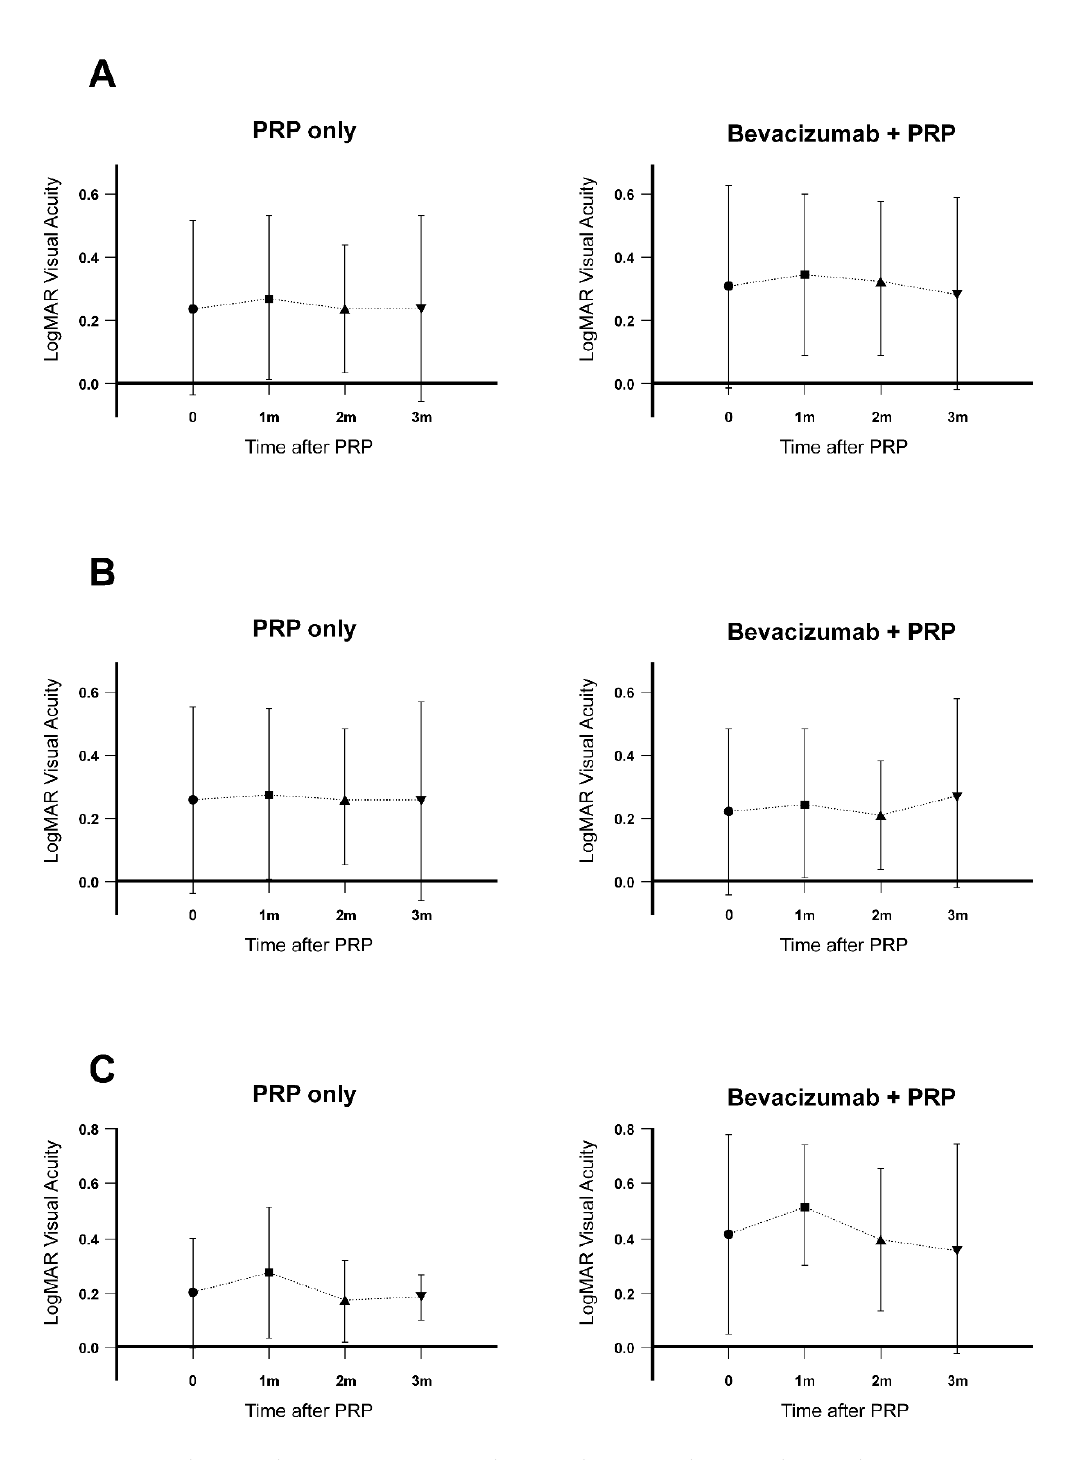
Figure 3. Visual acuity changes in patients with PDR who received PRP with or without preoperative IVB injection. Visual acuity was measured at baseline and one, two, and three months after PRP (** p < 0.05). ( A ) Overall changes in the logMAR visual acuity in the two groups. ( B ) Changes in the logMAR visual acuity in patients without baseline ME in both groups. ( C ) Changes in the logMAR visual acuity in patients with baseline ME in both groups. IVB: intravitreal bevacizumab, PRP: panretinal laser photocoagulation, PDR: proliferative diabetic retinopathy, logMAR: logarithm of the minimum angle of resolution, ME: macular edema.